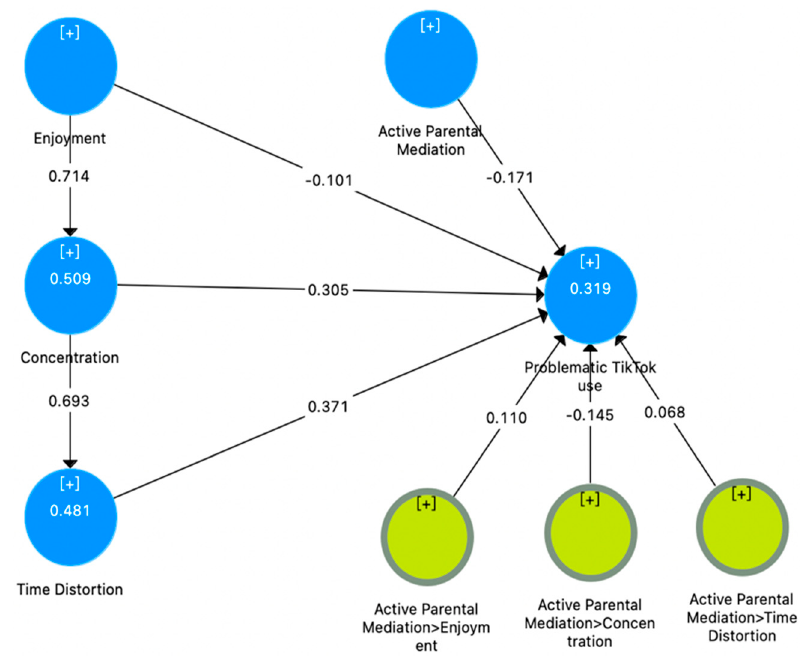
Figure A1. The Final Model based on Statistical Figure A1.The Final Model based on Statistical Results.